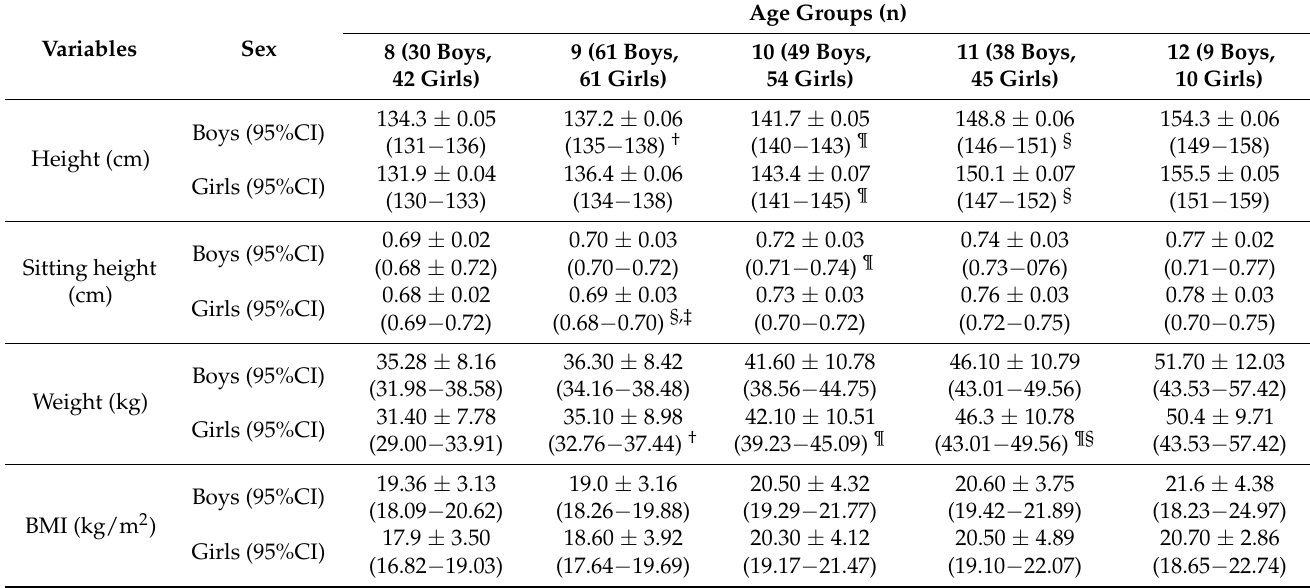
Table 1. Anthropometric characteristics of the participants (mean ± SD,